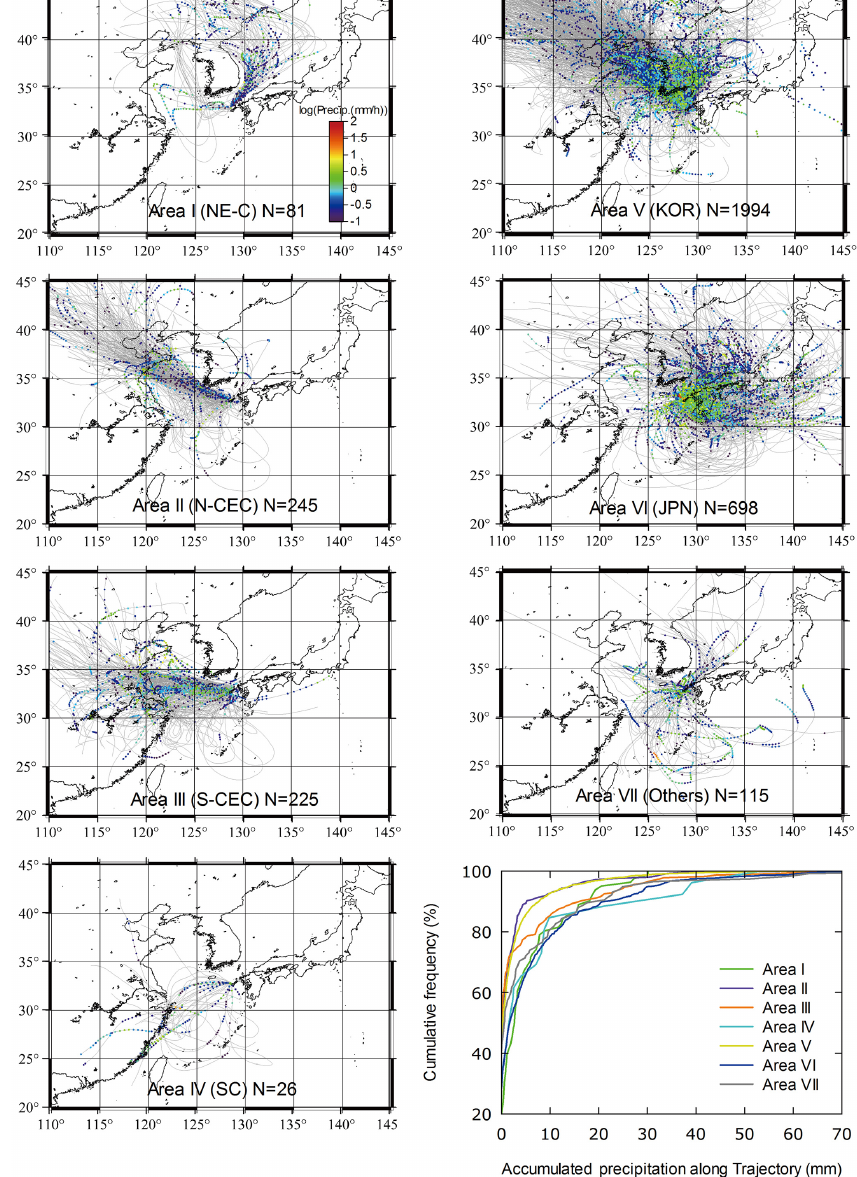
Figure 3. Backward trajectories for cases with valid (cid:49) BC /(cid:49) CO data were classified into seven air mass types. Gray thin lines indicate within 72h and at altitude less than 2500ma.s.l. Colored dots indicate precipitation rate (mmh − 1 , on log scale) and locations. Cumulative frequency (%) of APT for each category is shown in lower right